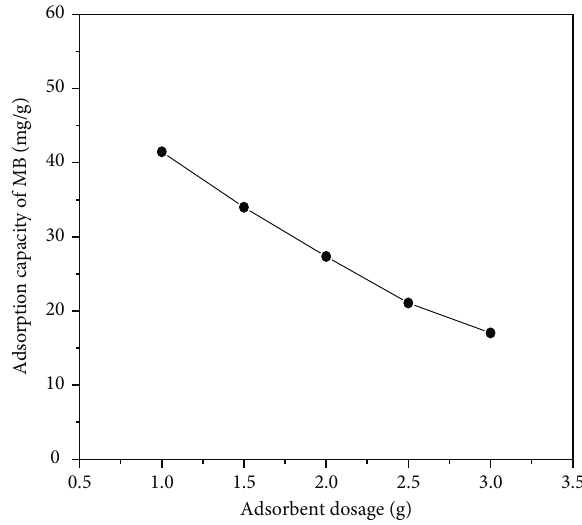
Figure 5: E ff ect of adsorbent dosage on removal of MB (pH 10, initial concentration 100ppm, and contact time 60 min).